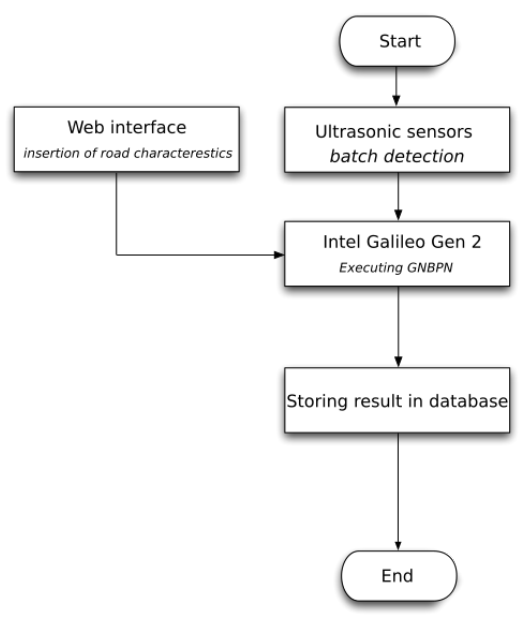
Figure 9. The flow diagram of the developed prototype.